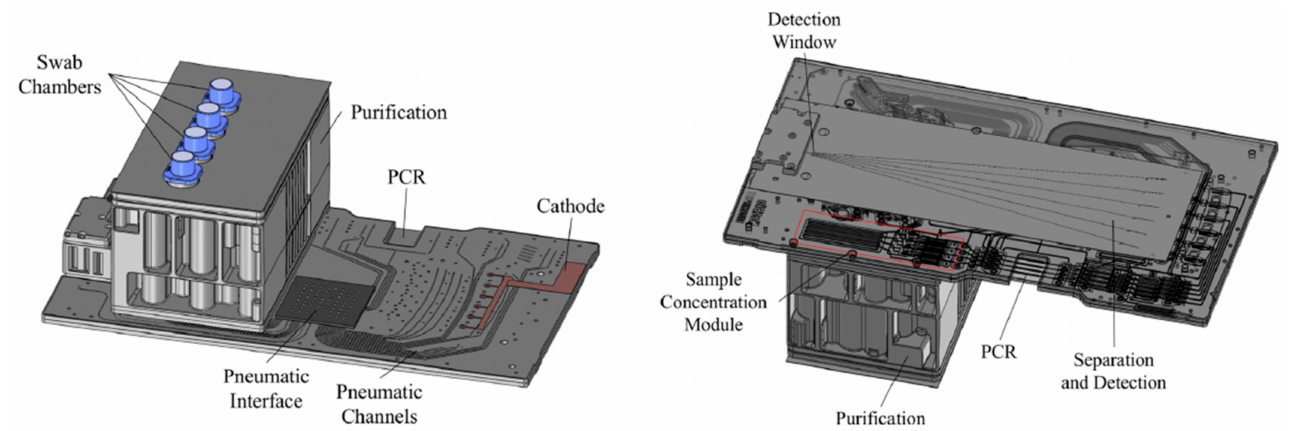
Figure 5. Schematic overview of the ANDE I-chip, with a top view ( left ) and a bottom view ( right ). Reprinted from